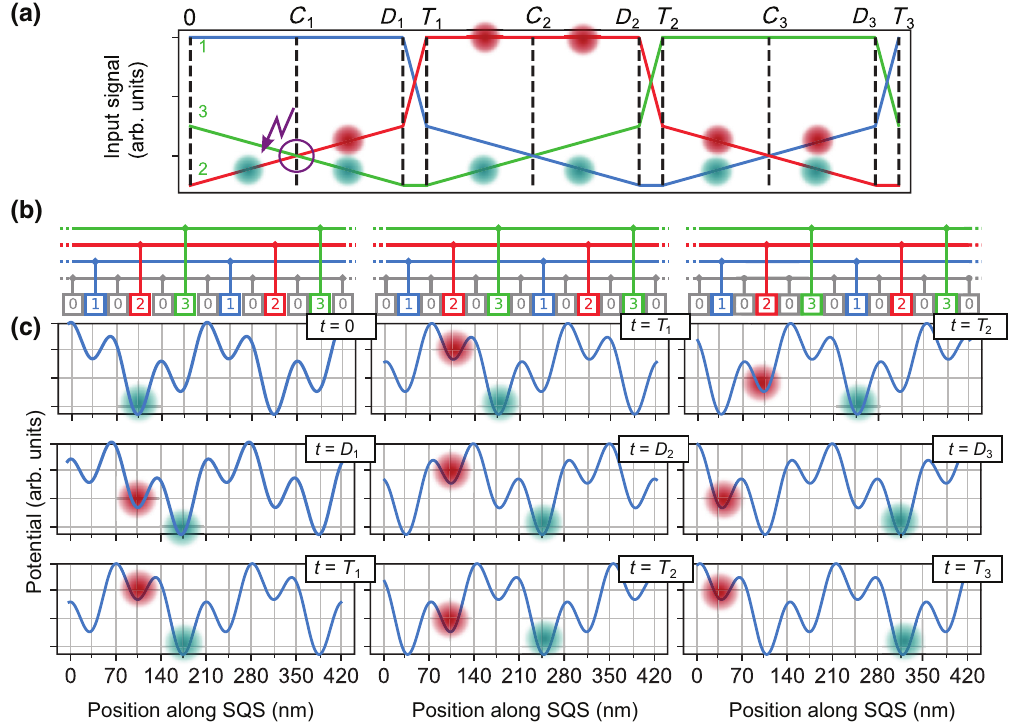
FIG. 4. Illustration of the propagation of an electron in BB mode for which the QD transfer fails once (red) and comparison with an electron, which follows the intended path (blue). (a) Three-input signal as a function of time applied to the gate sets labeled 1, 2, and 3 in (b). (b) Labeling of the clavier gates and electrical connection. Fixed voltages are applied to all barrier gates, labeled 0. (c) Sketch of the potential in the QW along the SQS channel aligned with the clavier gates in (b). The potential plotted in each subpanel corresponds to a different time t labeled in (a). Blue circles show the intended position of the shuttled electron and red circles mark the expected electron position in the case of a failed LZR transition marked by the circle in